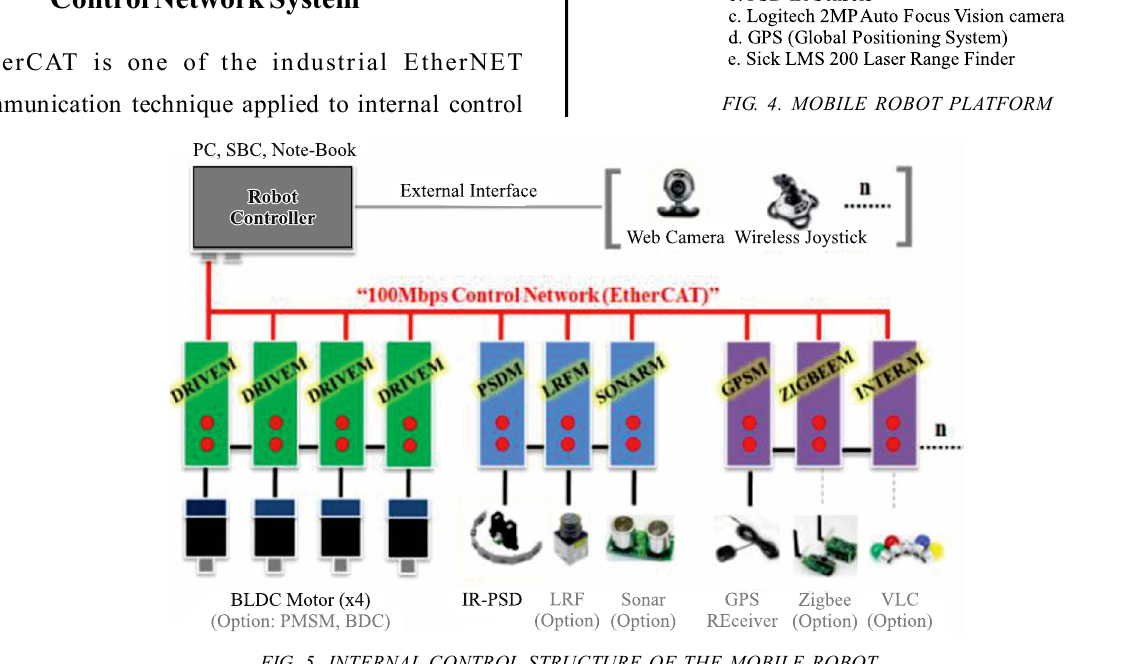
FIG. 5. INTERNAL CONTROL STRUCTURE OF THE MOBILE